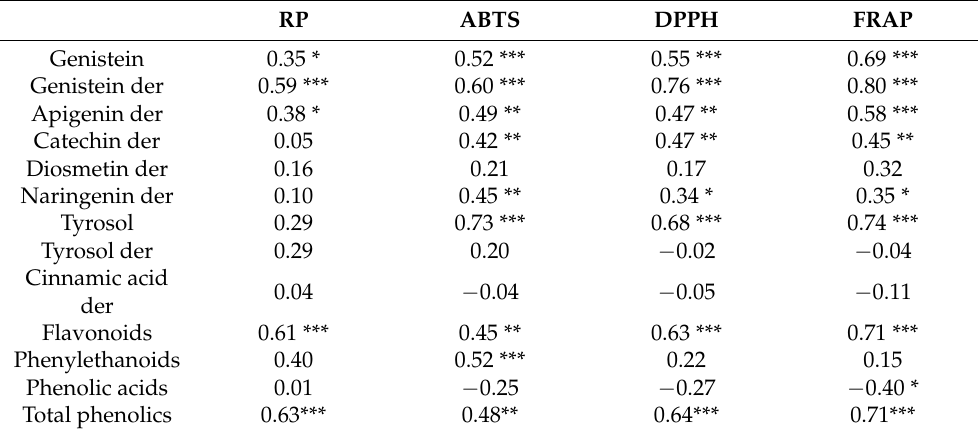
Table 2. Pearson’s linear correlation coefficients (n = 38) among antioxidant capacity (RP, reducing power; ABTS, 2,2’-azino-bis (3-ethylbenzothiazoline-6-sulfonic acid); DPPH, 2,2-diphenyl-1-picrylhydrazyl; FRAP, ferric reducing antioxidant power) and free phenolics content of all Lupinus samples. RP ABTS DPPH FRAP Genistein 0.35 * 0.52 ***